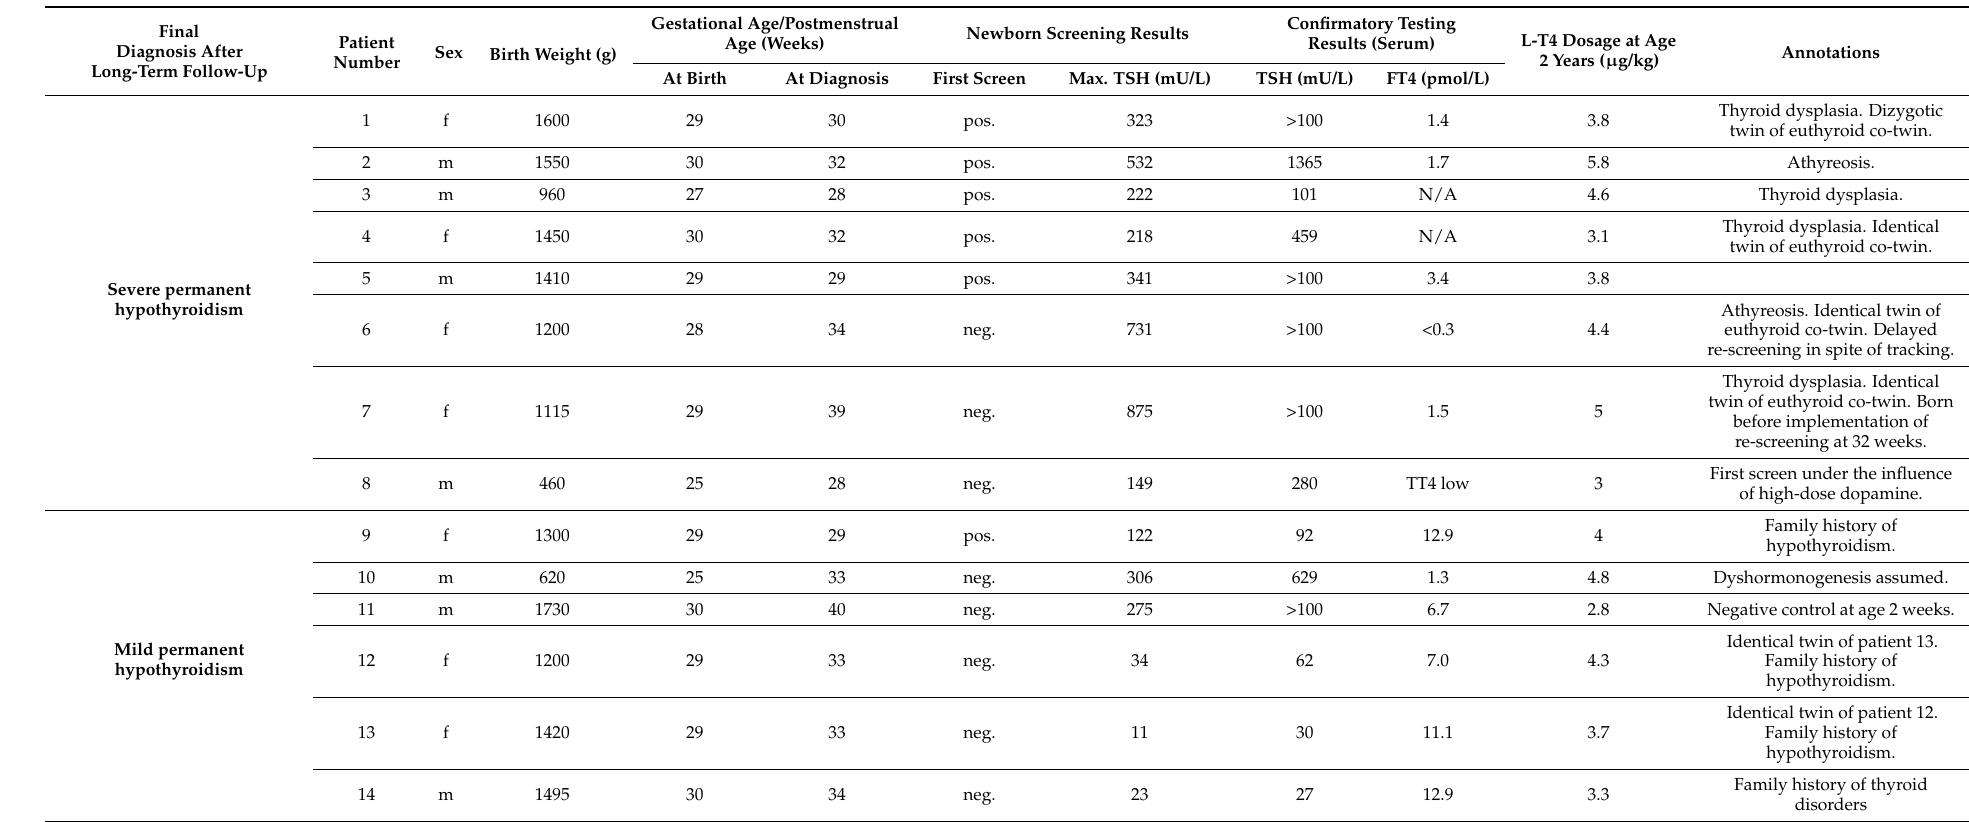
Table 2. Individual patient